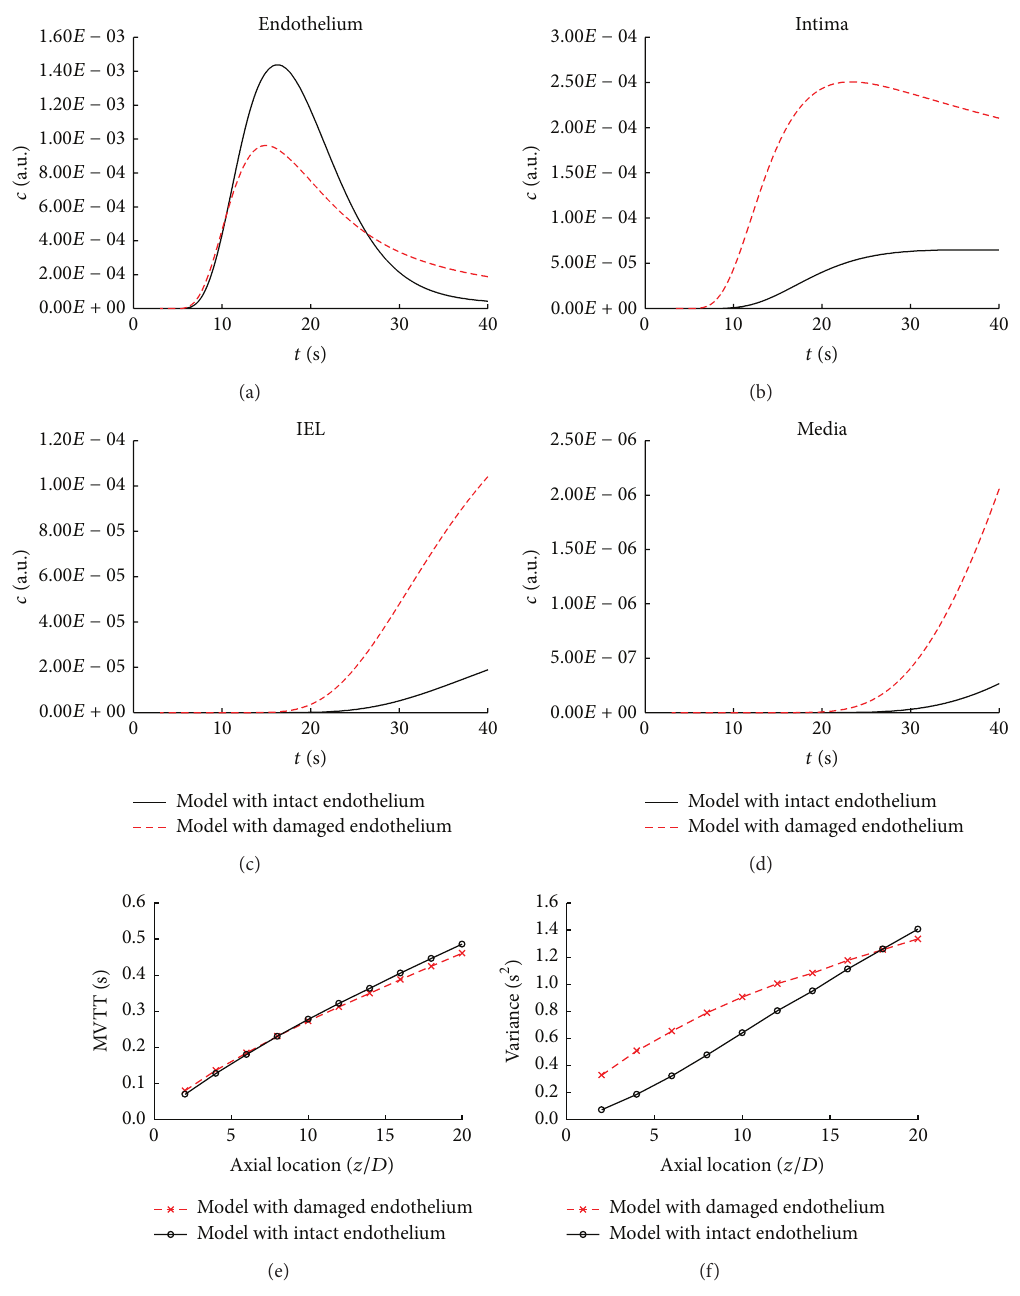
Figure 5: Effects of endothelium on contrast agent transport and the bolus dispersion in the unstenosed model. (a–d) Comparison of the concentration-time curve across the arterial wall between the damaged endothelium model and the intact one at the axial direction of 10𝐷 . (e-f) Comparison of the quantitative parameters of the bolus delay (MVTT) and dispersion (variance) between the damaged endothelium model and the intact